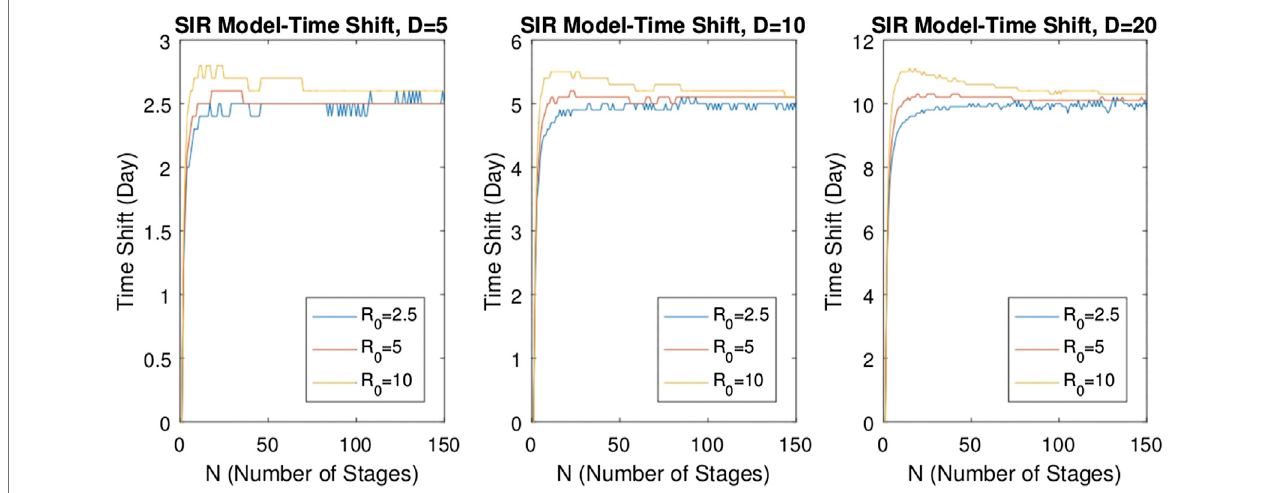
FIGURE 10 | Variations of time shift (delay) with respect to the number of stages N for R 0 (cid:2) 2 . 5 , 5, and 10; D (cid:2) 5 , 10, and 20 in the multistage SIR model. For all cases, the time shift becomes stable at a constant value after a critical stage number N .